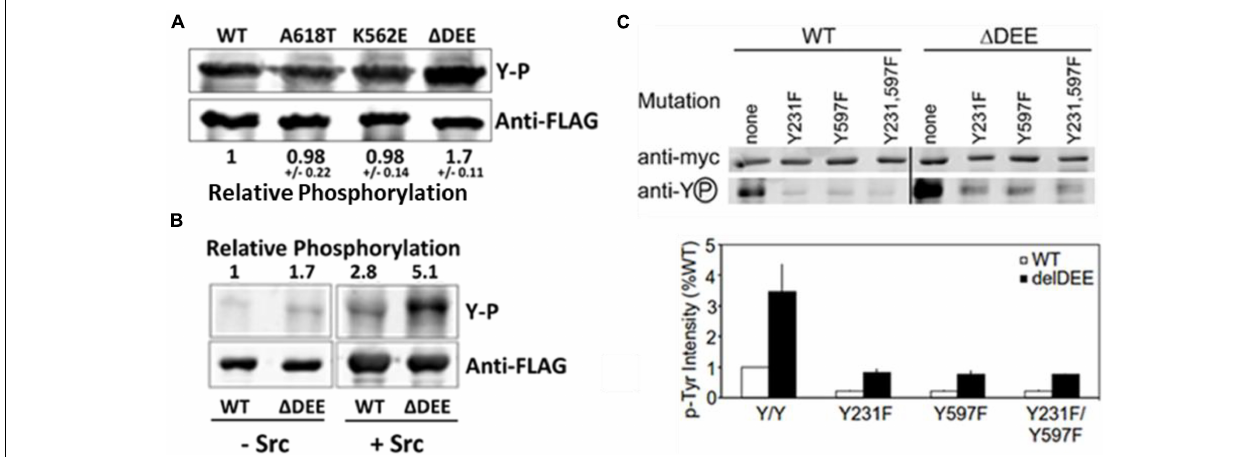
FIGURE 4 | Enhanced tyrosine phosphorylation of DNM2 (cid:49) DEE . (A) . Phosphorylation in cells. HeLa cells were co-transfected with Src and DNM2s, cell lysates were immunoprecipitated with anti-FLAG Abs and the electrophoresed precipitates were probed with anti-P-Y and anti-FLAG Abs. (B) . Phosphorylation in vitro . FLAG-tagged DNM2 WT and DNM2 (cid:49) DEE were immunoprecipitated from transfected HEK293 cells with anti-FLAG Abs. The beads with immunoprecipitated proteins were treated with alkaline phosphatase (AP, then incubated with or without purified Src. P-Y levels were quantified by LiCOR scanning after blotting with anti-P-Y and anti-FLAG for normalization. (C) . Effect of mutations of putative tyrosine-phosphorylated residues. HeLa cells were co-transfected with myc-tagged dynamins and Src. Lysates were immunoprecipitated with anti-myc antibodies and dynamins were pulled down with protein A/G Sepharose. Samples were electrophoresed and blotted with anti-myc and anti-P-Y antibodies.